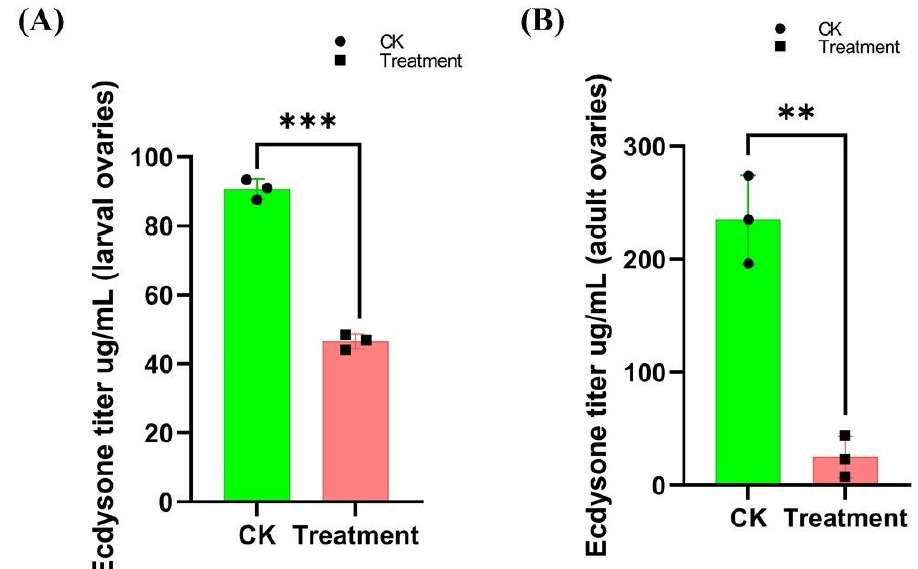
Figure 5. Effect of cyromazine on the ecdysone titer of larval and adult ovaries. ( A ) Ecdysone titer from the larval ovaries. Due to the small size of the larval ovaries, a total of 300 larval ovaries were dissected for each replication (N = 900, total number of larval ovaries dissected for each experiment). ( B ) For determining ecdysone titer from the adult ovaries, 20 ovaries were dissected for each replication (N = 60, total number of adult ovaries dissected for each experiment). The p -value of Student’s t -test is: ** p < 0.01; *** p < 0.001.